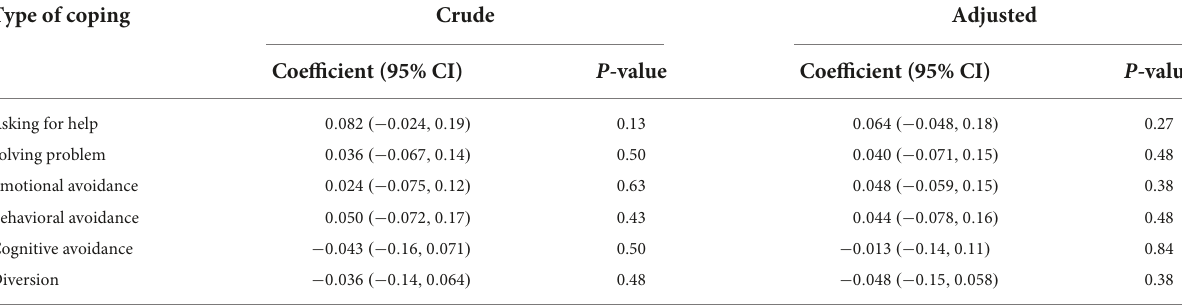
TABLE 4 Effect of each coping skill as a moderator on the association between bullying experience and self-esteem